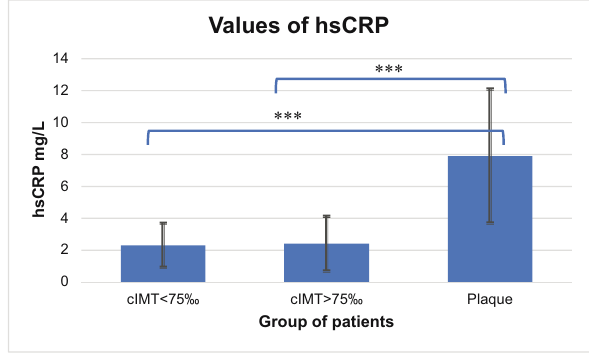
Figure 2: Values of circulating hsCRP in di ff erent groups of patients according to the vascular changes ( * p < 0.05; ** p < 0.01; *** p < 0.001 )